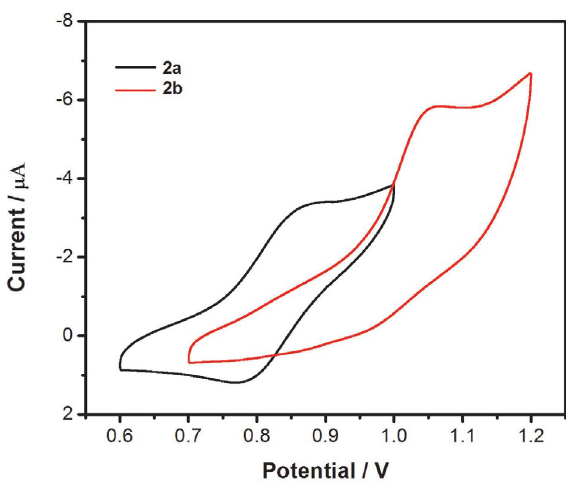
Fig. 5. Cyclic voltammograms for complexes 2a – 2b in CH 2 Cl 2 solu- tion containing n -Bu 4 NClO 4 (0.1 M) at a sweep rate of 100 mV/s.